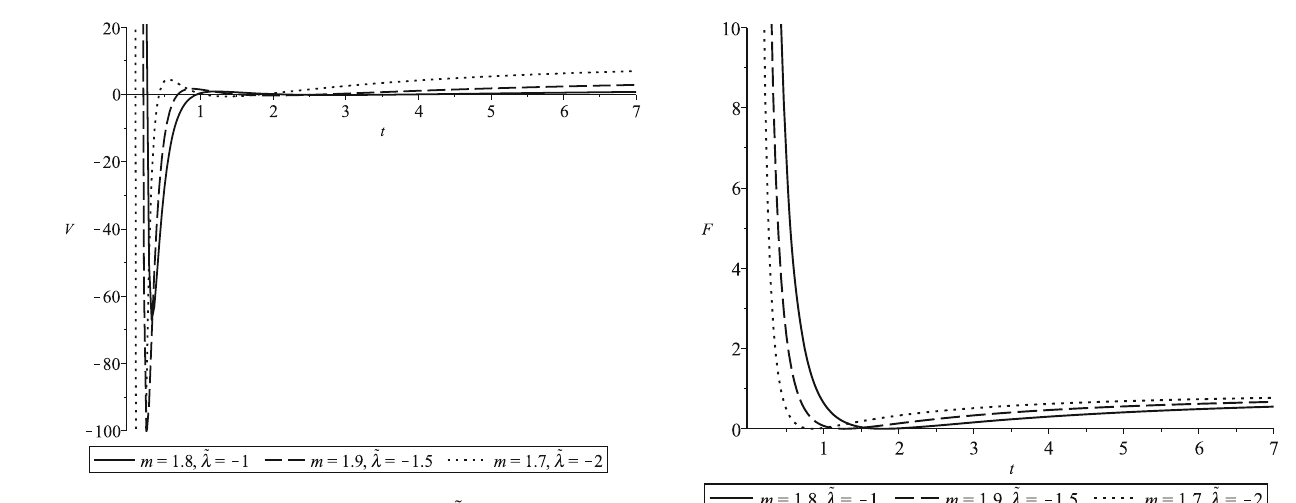
Fig. 2 Potential energy for different values of ˜ λ < 0 and m > 1